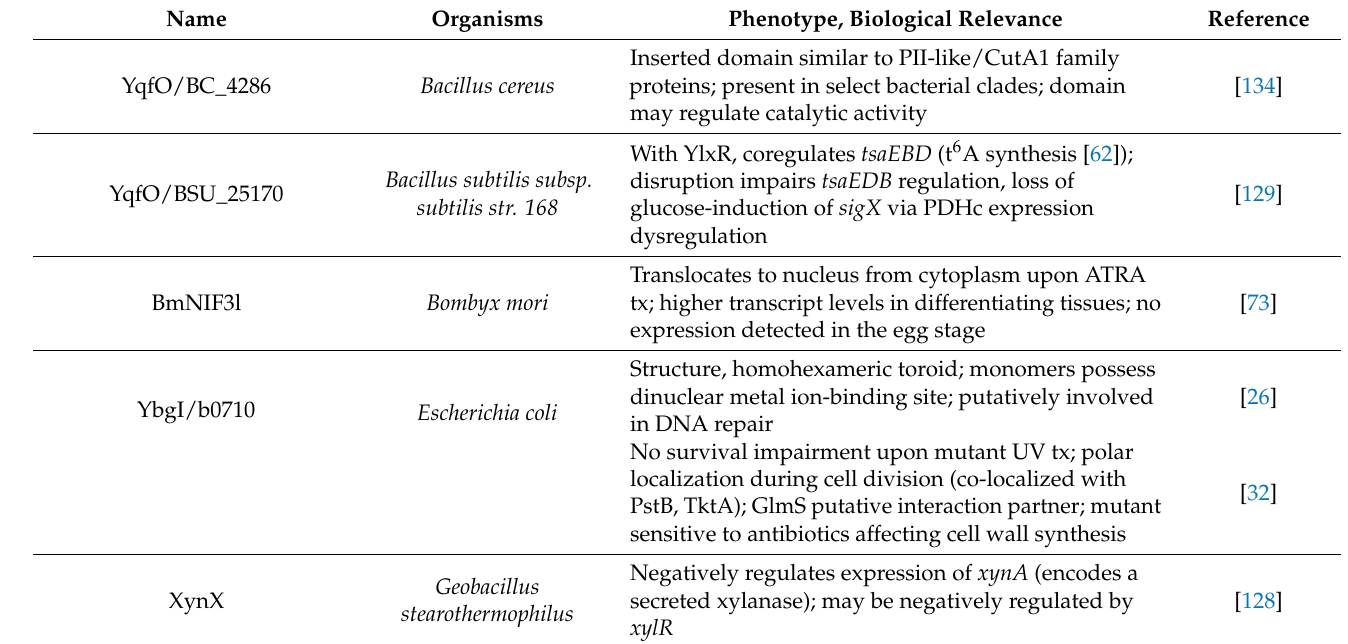
Table 1. Focal publications featuring members of the DUF34 protein